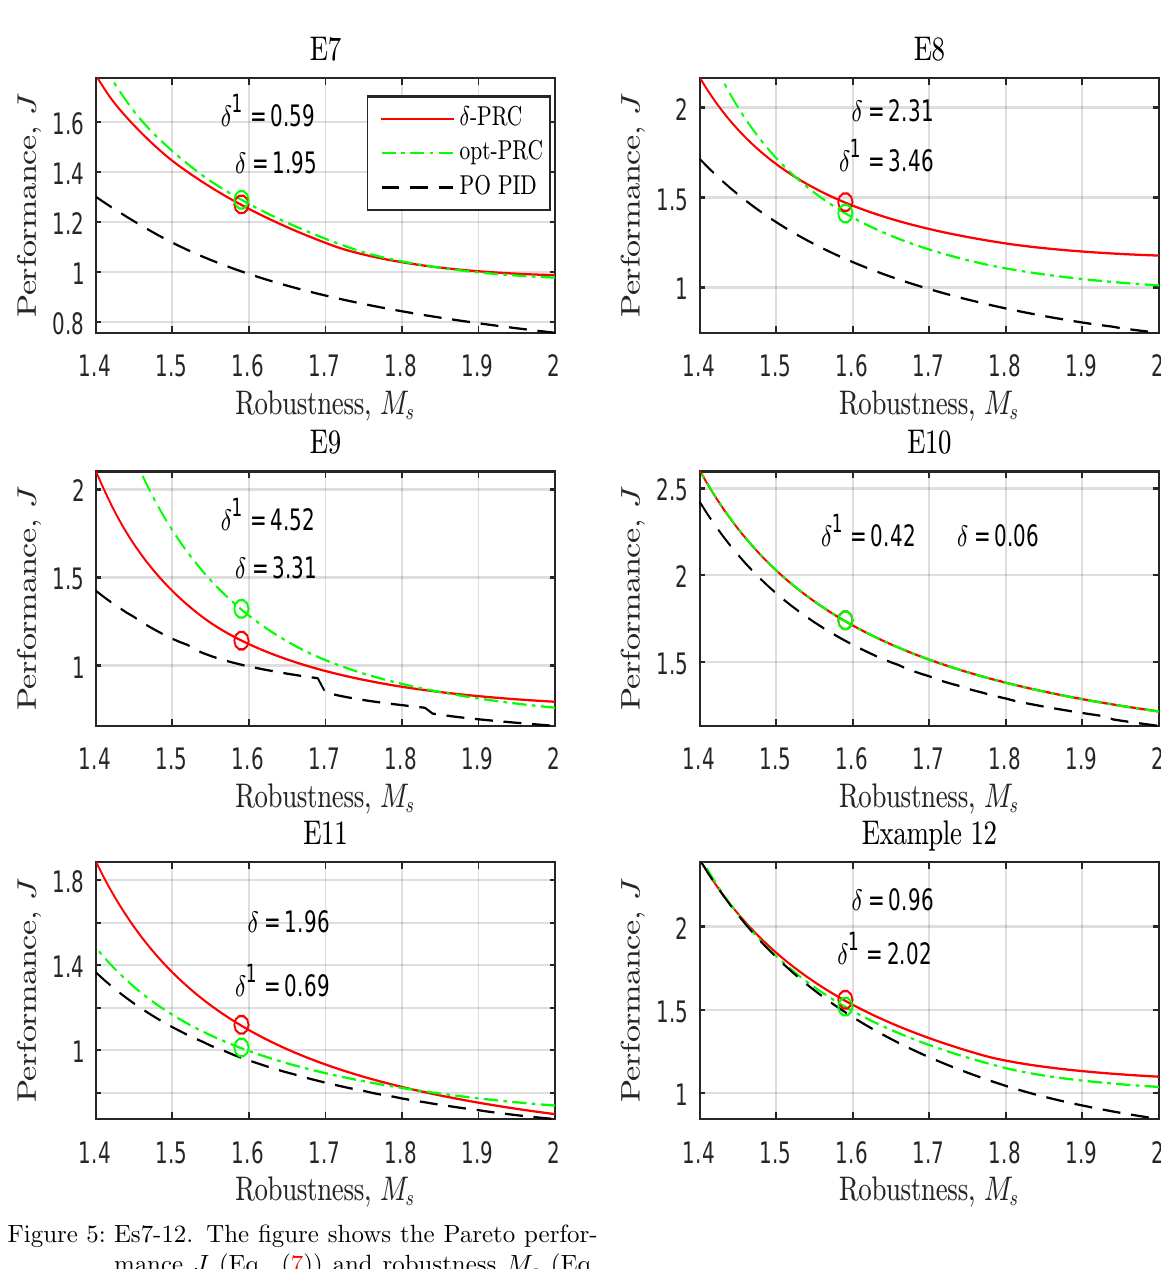
Figure 5: Es7-12. The figure shows the Pareto perfor- mance J (Eq. (7)) and robustness M s (Eq. (5)) trade-off curves for the methods δ -PRC ( δ ), Opt-PRC ( δ 1 ) and PO PID ( M s ), where δ and δ 1 are the prescribed relative time de- lay errors. The circles illustrates controllers with prescribed robustness M s = 1 .